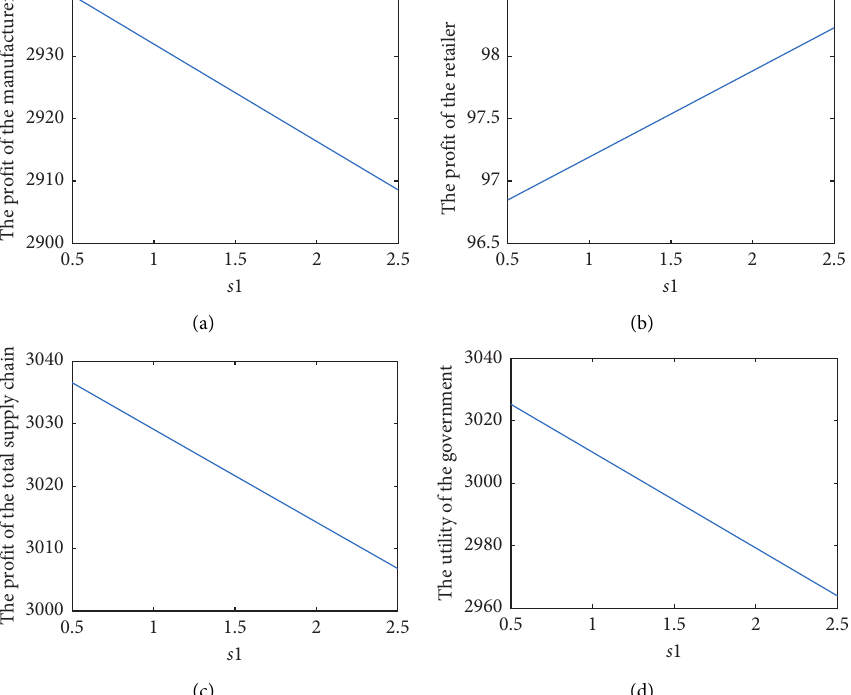
Figure 7: The effect of the government’s subsidy coefficient to the manufacturer s